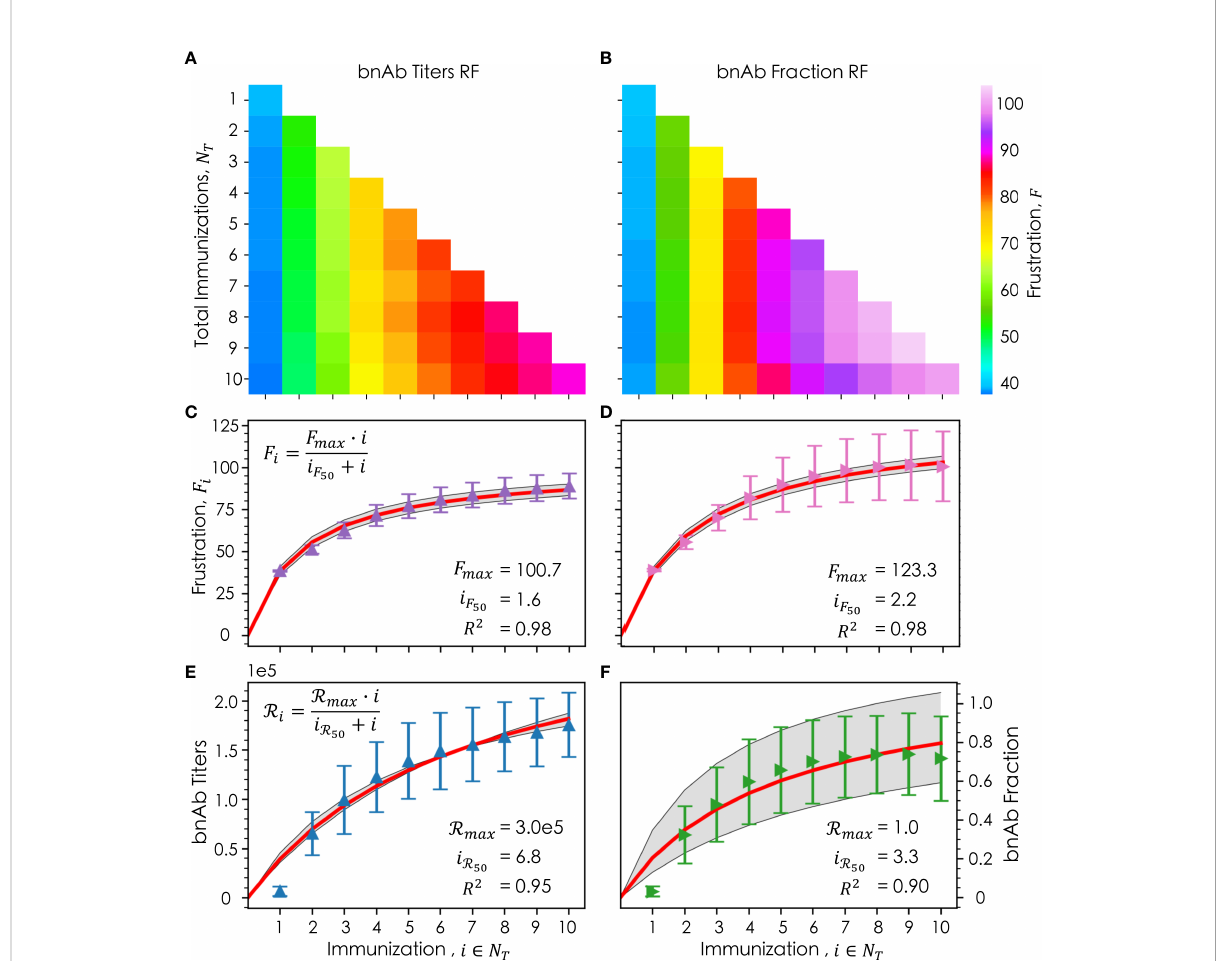
FIGURE 5 Frustration values of a given immunization, i , out of a total number of immunizations, N T , where the column corresponds to the i th immunization, and the row corresponds to the total immunizations for both the (A) bnAb titers reward function and (B) bnAb fraction reward function; the average frustration for a given immunization, F i , averaged across all N T for (C) the bnAb titers reward function (purple) and (D) the bnAb fraction reward function (pink), with their respective Michaelis-Menten saturation fi ts (red) +/- the standard deviation (gray); the average reward for a given immunization, R i , for the bnAb titers reward function ( E , blue) and bnAb fraction reward function ( F , green), with their respective fi ts (red) and standard deviation of the fi t (gray). In (C – F) , the error bars represent the standard deviation. Fitted parameters for the Michaelis-Menten model are shown in (C – F)